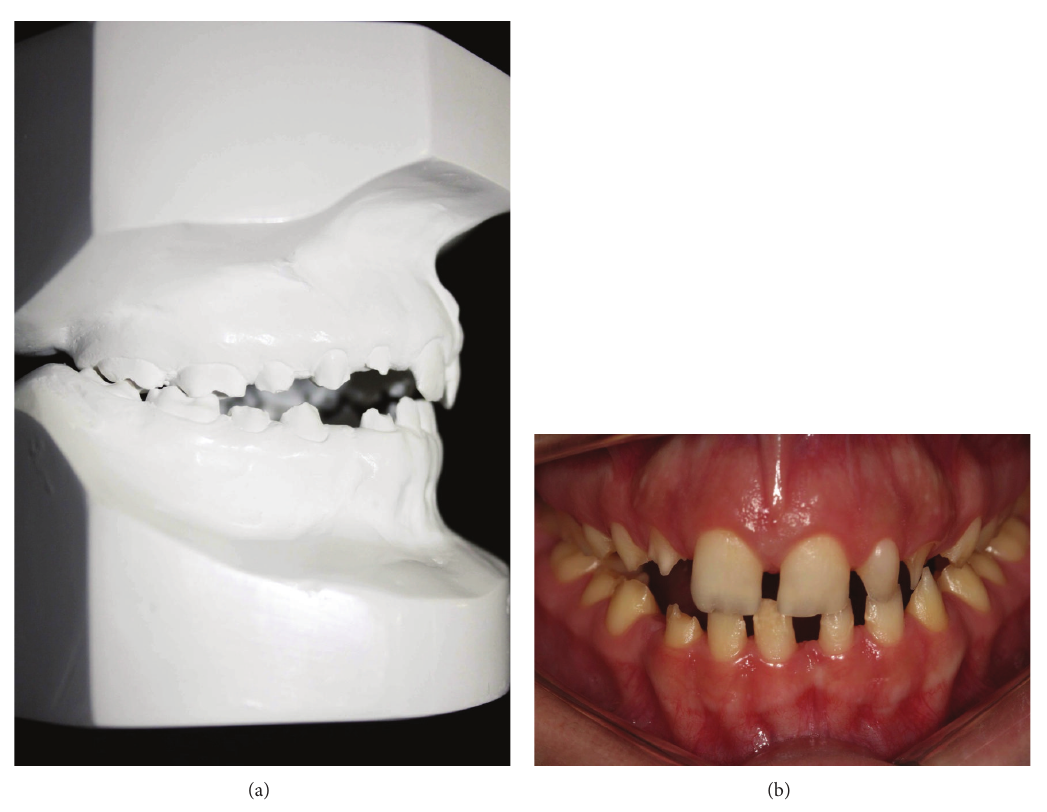
Figure 2: (a) The orthodontics appliance. (b) After orthodontic treatment (6